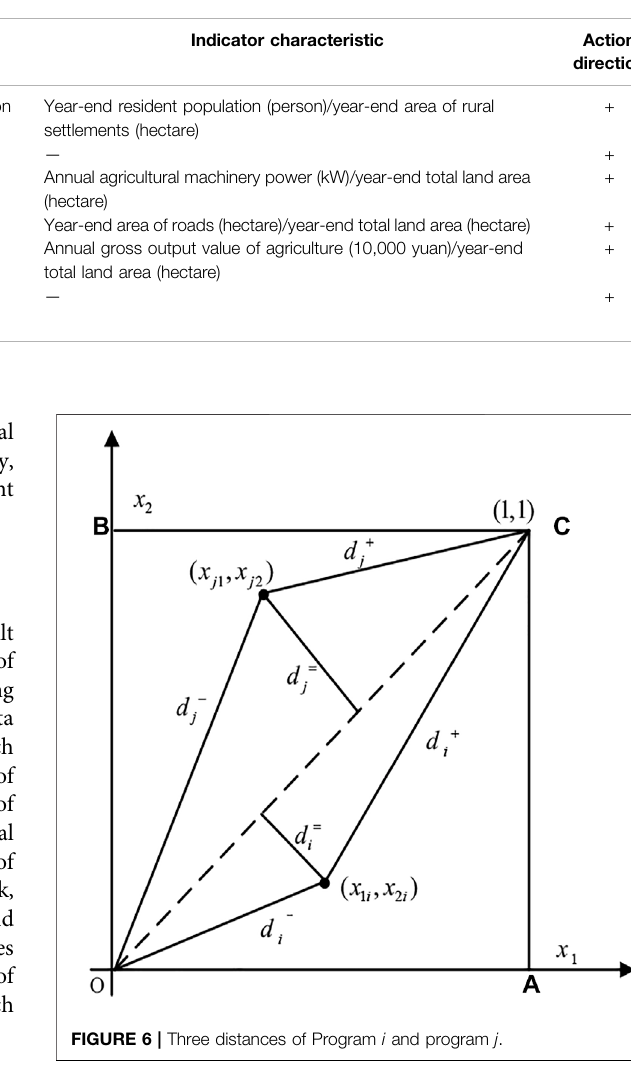
TABLE 1 | Rural vitality evaluation index system.